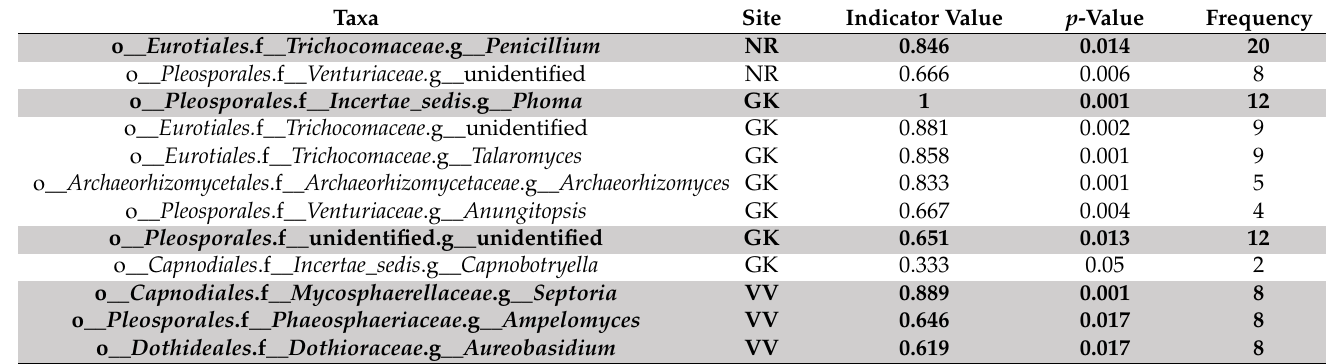
Table 2. Representative fungal taxa in peat samples as determined by indicator species analysis. All were assigned to the phylum Ascomycota . Taxa with the highest frequency for each site are highlighted. o = order; f = family; g = genus; NR = Nuwejaars River system (developing peatland); GK = Goukou River system (impacted peatland); VV = Vankervelsvlei (undisturbed peatland). Taxa Site Indicator Value p